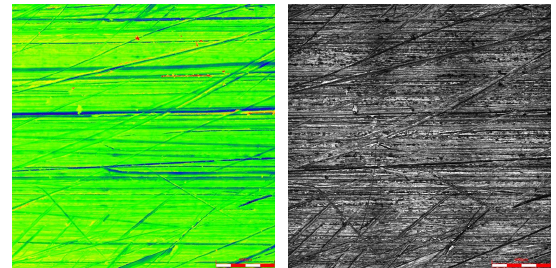
Figure 5. Detail of the tube surface